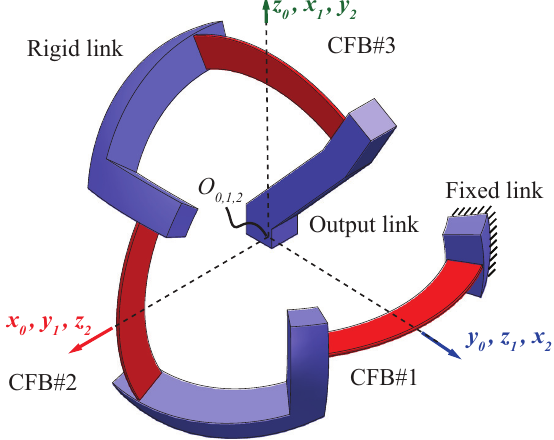
Figure 3. CFB-based spherical open